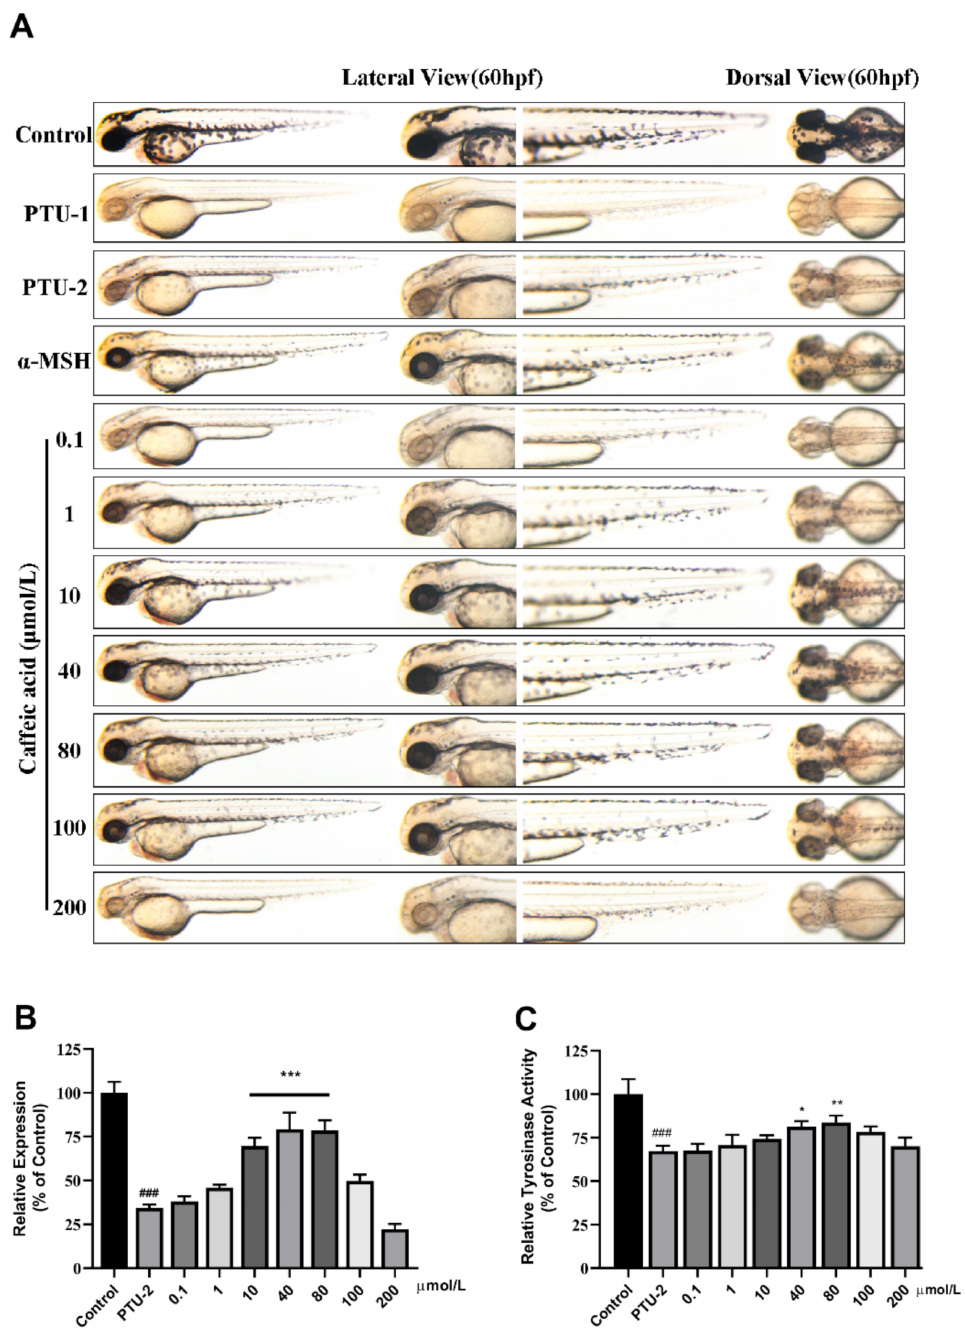
Figure 5. Effect of caffeic acid on melanogenesis in vivo. ( A ) Zebrafish melanin phenotype in various concentrations of caffeic acid [0.1, 1, 10, 40, 80, 100 and 200] µ mol · L − 1 , the α -MSH is 60 µ mol · L − 1 , and the PTU-1 group was not washed at all while the PTU-2 group was washed before administration. ( B ) Collecting zebrafish in each group for testing melanin content (relative expression % of control). ( C ) Tyrosinase activity in zebrafish exposure to butin for 24 h. In ( B , C ), results shown are mean ± SEM. Data were analyzed by ANOVA followed by post hoc Tukey test. n = 30 zebrafish, ### p < 0.001 vs. Control, *** p < 0.001, ** p < 0.01, * p < 0.05 vs.